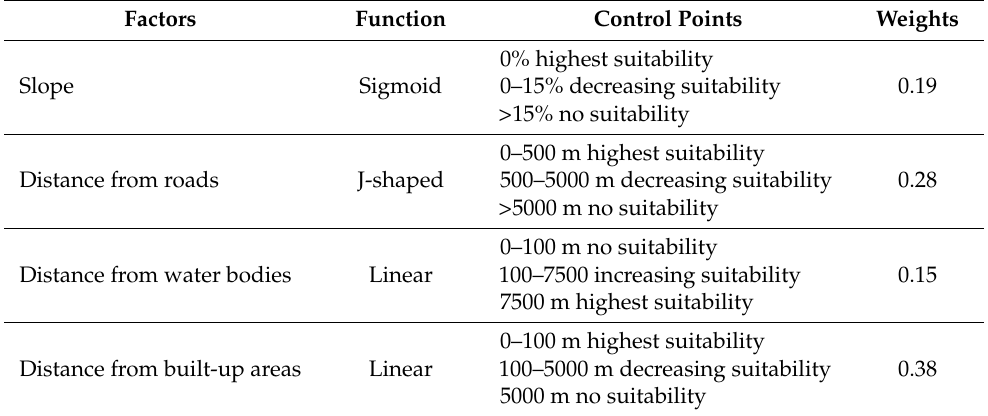
Table 3. Extracted weights on analytic hierarchy process (AHP) and fuzzy standardization for urban areas.